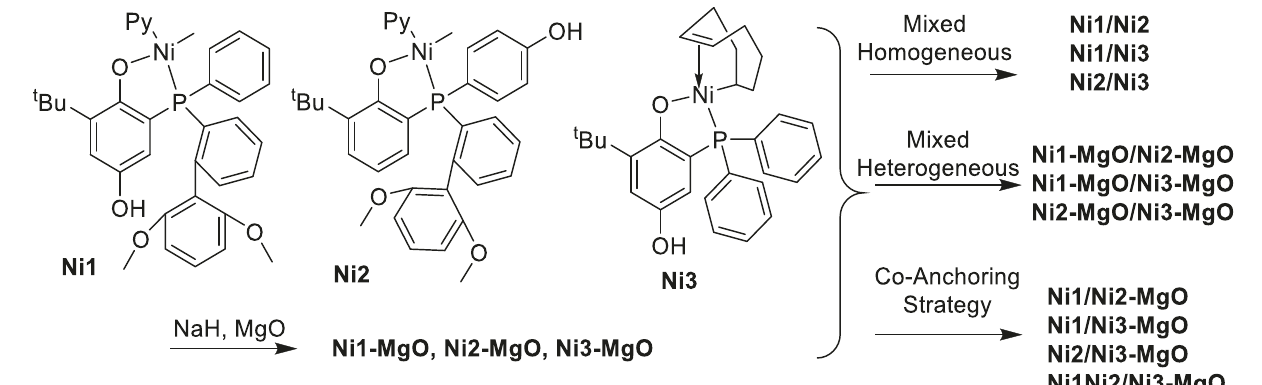
Fig. 2 | Synthesis of desired catalysts. Synthesis of mixed homogeneous catalysts, mixed heterogeneous catalysts, and co-supported catalysts by the co-anchoring strategy.